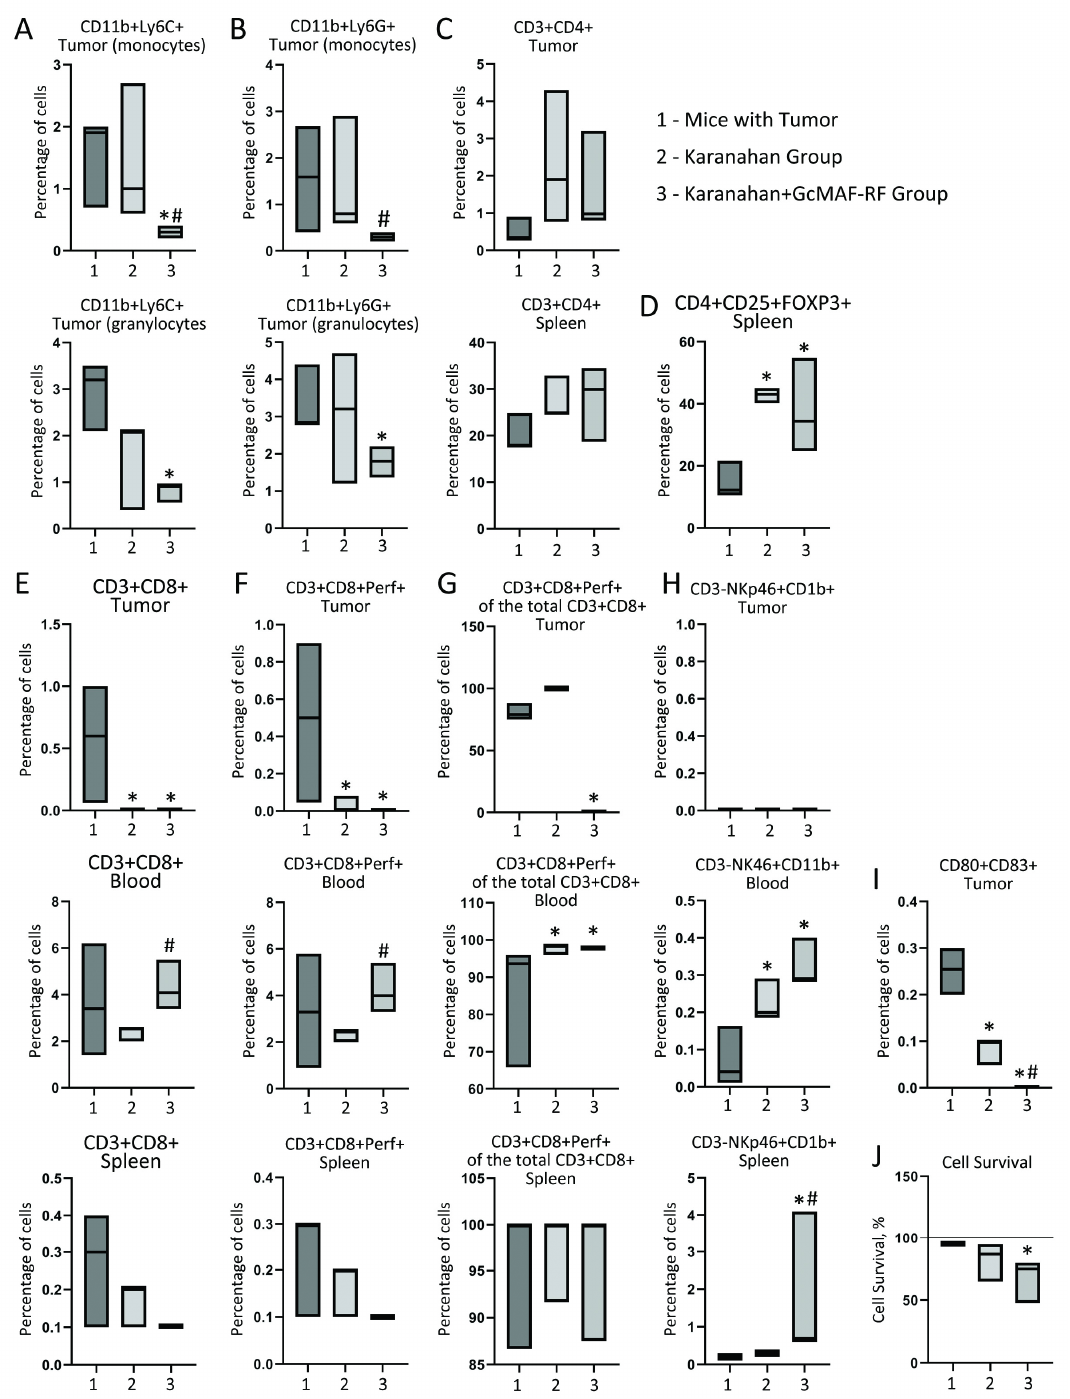
Figure 7. The additive effect of GcMAF on primary induction of the immune response by Karanahan therapy in mice with Lewis carcinoma on day 16. ( A ) CD11b + LyC + cells. ( B ) CD11b + LyG+ cells. ( C ) CD3 + CD4 + cells. ( D ) CD4 + CD25 + FOXP3+ cells. ( E ) CD3 + CD8 + cells. ( F ) CD3 + CD8 + Perf + killer T cells. ( G ) CD3 + CD8 + Perf + cells among CD3 + CD8 + cells. ( H ) CD3-NKp46 + CD11b + cells. ( I ) CD80 + CD83 + cells. The black asterisk shows a significant difference between the control and experimental groups. The hash stands for a significant difference between the experimental groups. The confidence level is p < 0.05 (Mann–Whitney U test, n = 3). ( J ) Cytolytic activity of PMs against Lewis carcinoma cells. Median (line) with interquartile range (box) are shown.